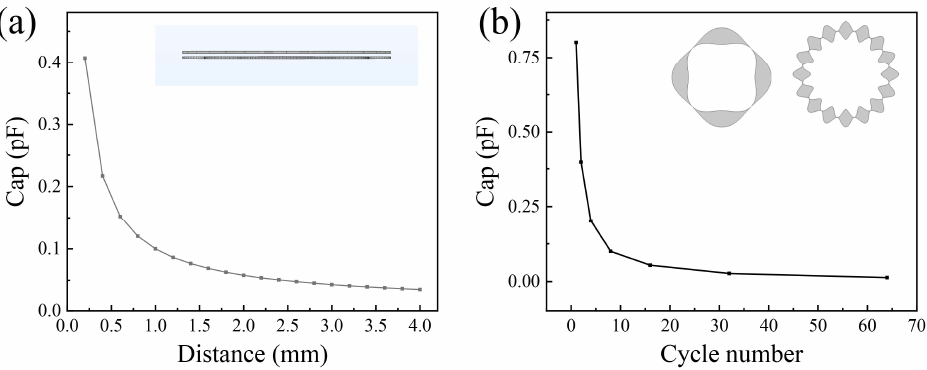
Figure 3. The parameter selection: ( a ) the relationship between the minimum capacitance and the air domain interval distance and ( b ) the relationship between the minimum capacitance and the number of cycles X; 4 and 16 cycles are examples in the illustration.